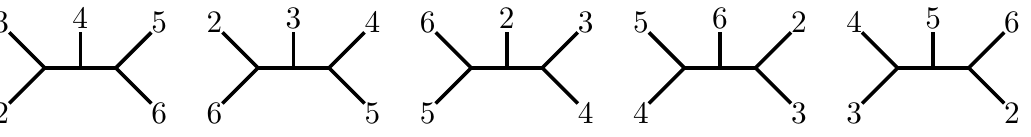
Figure 8 . Five possible planar graph for the first tree of any six-point planar